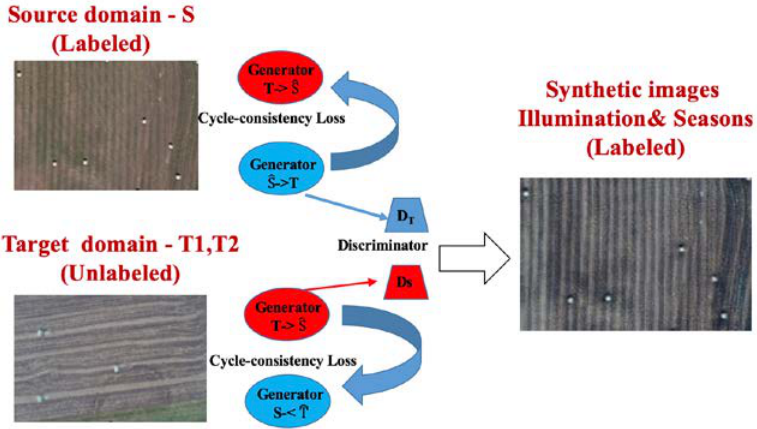
Figure 5. Framework of the domain adaption algorithm in Step 2.